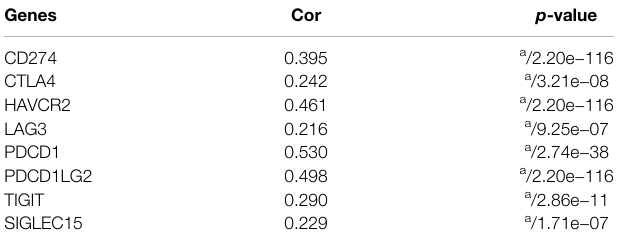
TABLE 1 | Correlation of TUBA1C with immune-checkpoint in